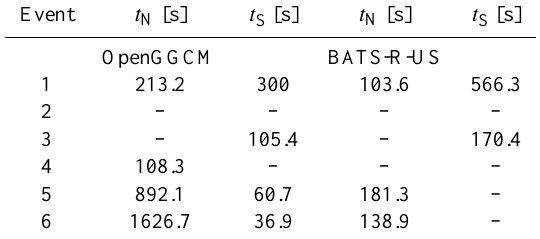
Table 6. Vortex dimensions for both hemispheres in the ionosphere at 100km altitude using v ph ≈ v HT .